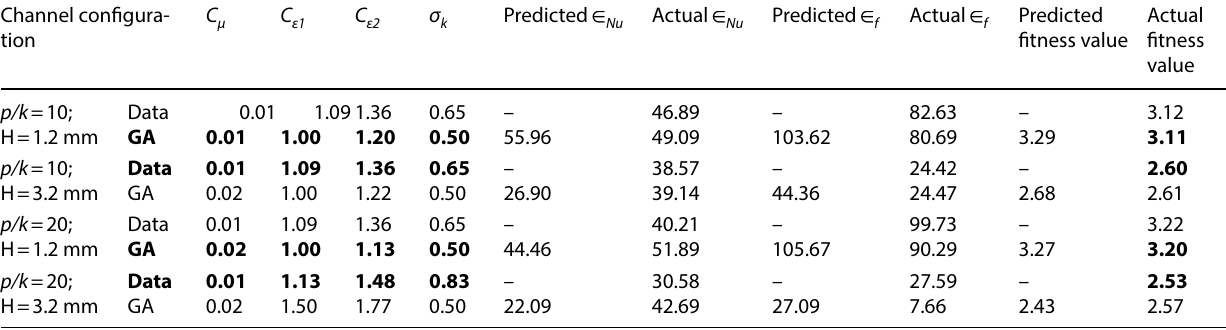
Table 6 Comparison between predicted and actual fitness values for prospective calibration values Channel configura- tion